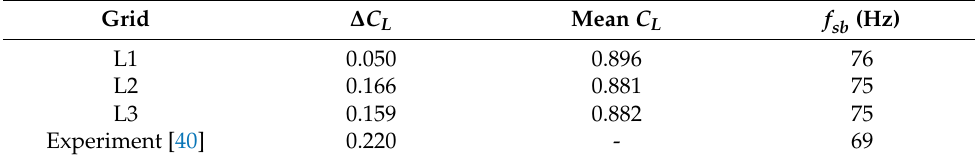
Table 2. The computed buffet characteristics using different levels of